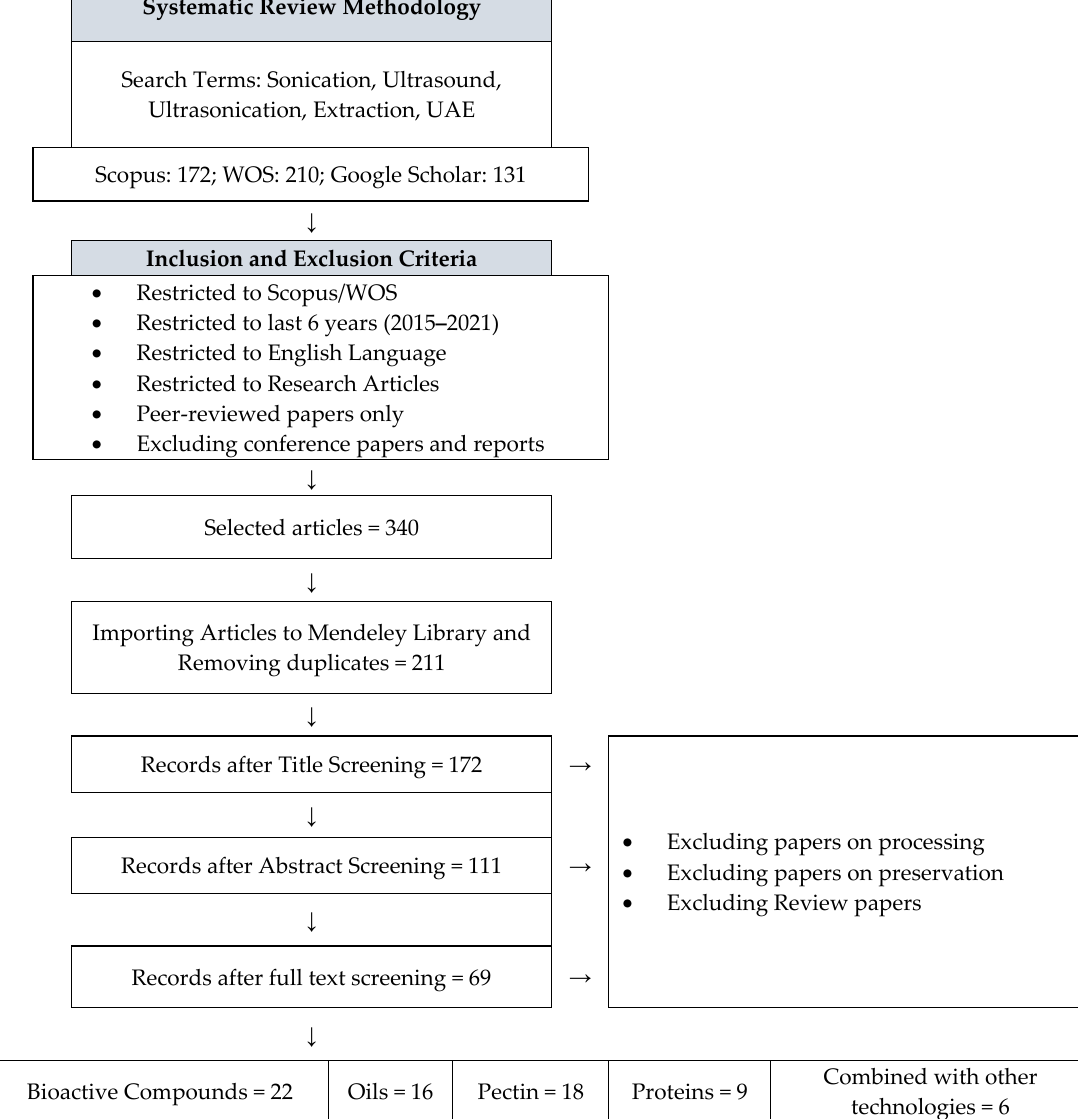
Figure 1. Methodology for systematic literature review.